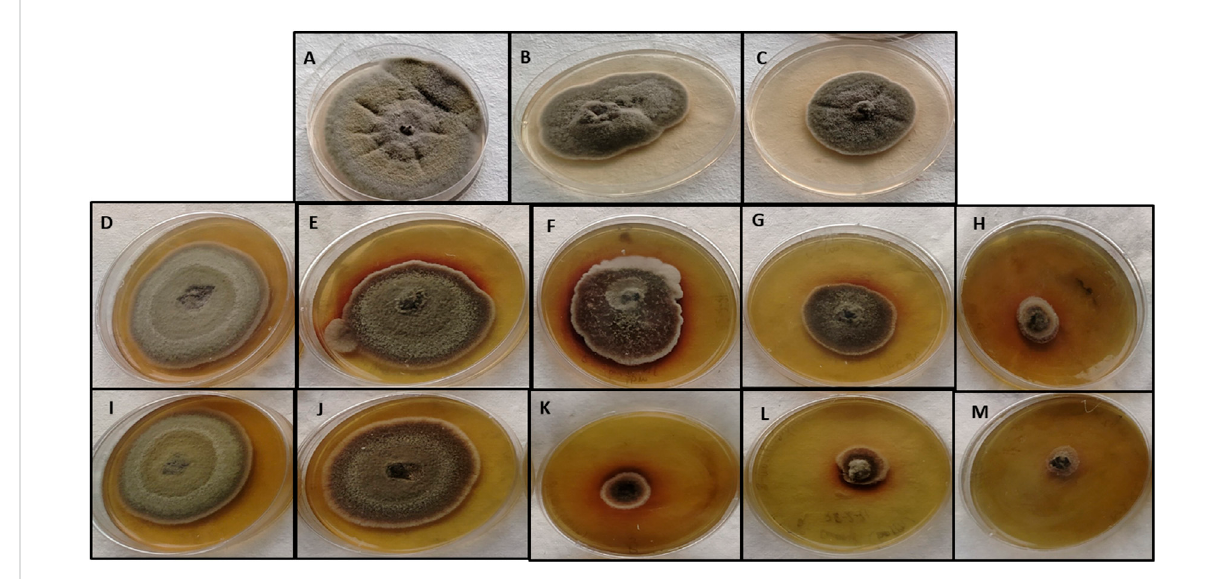
FIGURE 8 Antifungal activity of M-CuO NPs and C - CuO NPs (A,B,C) : control, Mancozeb (0.2%) and Propiconazole (0.05%); (D – H) C-CuO NPs — 25, 50, 100, 150, and 200 ppm; (I – M) M - CuO NPs — 25, 50, 100, 150, and 200 ppm.